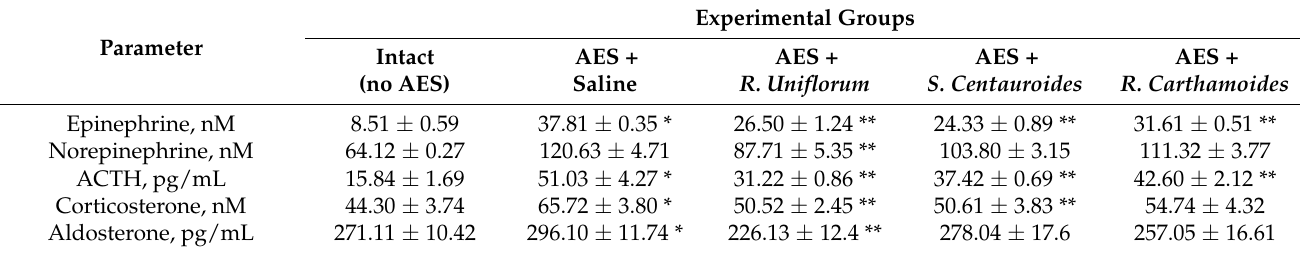
Table 4. The effect of R. uniflorum and S. centauroides extracts on the content of stress hormones in the blood in rats exposed to acute emotional stress